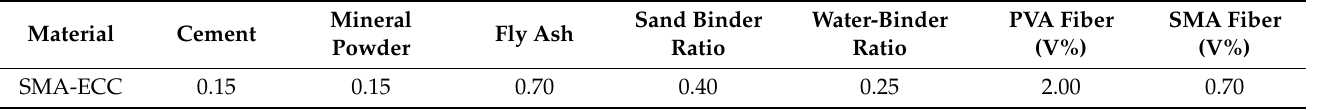
Table 3. Mix proportion of